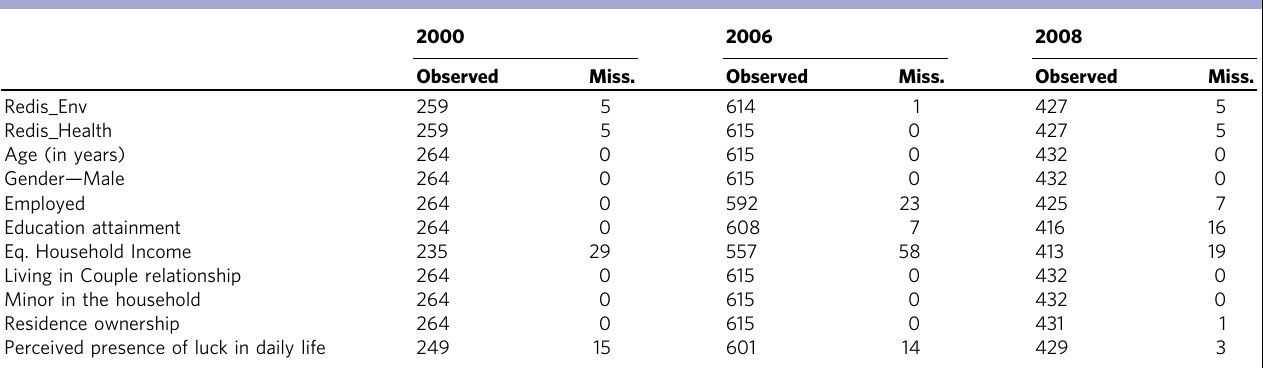
Table 3 Descriptive statistics for missing